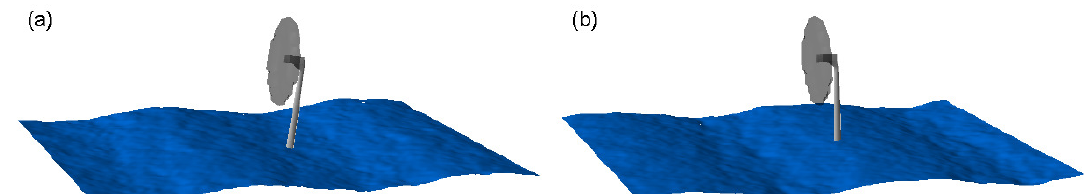
Figure 2. Illustration of turbine pitch motion caused by swell waves: ( a ) turbine at its maximum downwind pitch position when swell’s forward slope arrives and ( b ) turbine at its maximum upwind pitch position when swell’s backward slope